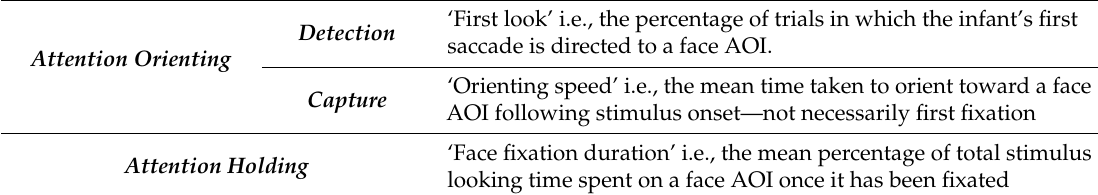
Table 1. Definitions of variables.